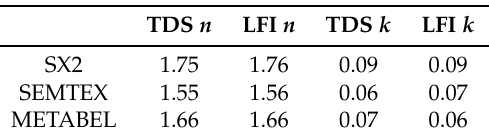
Table 2. Values for n and k for the three plastic explosives: comparison of TDS and laser feedback interferometry (LFI)